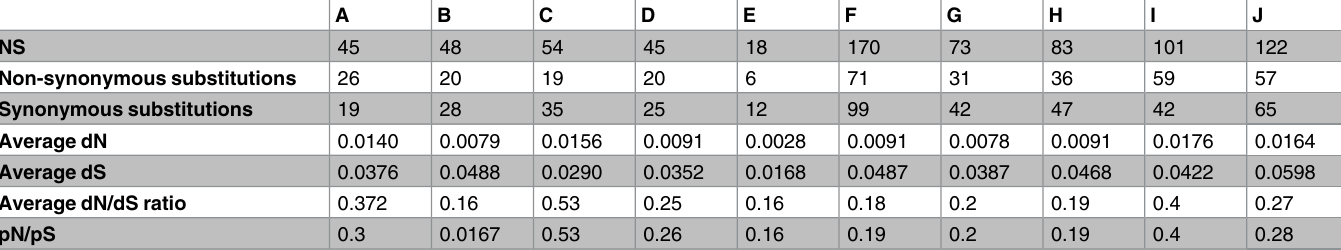
Table 2. Demonstration of the polymorphism and the average SNPs among the B . bovis 6-Cys gene family members among different distinct